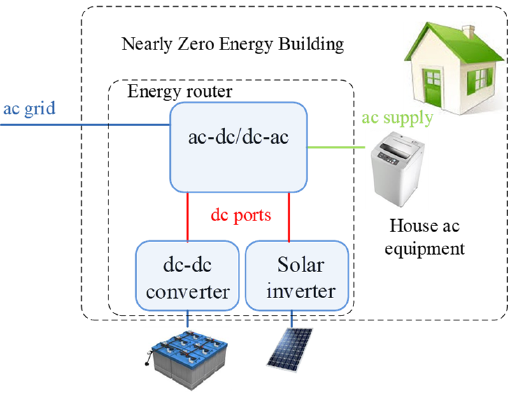
Figure 1. Energy router for NZEB.